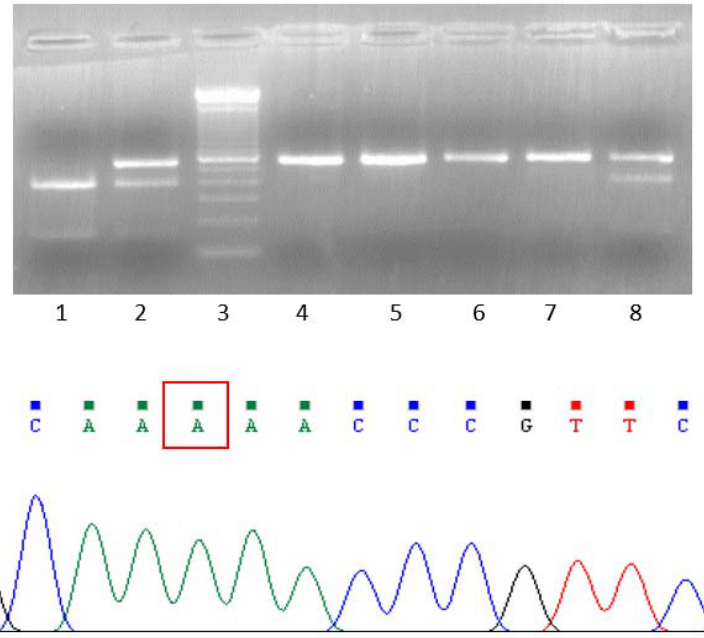
Figure 1. Melanoma tumors showing homozygosity of MITF-E318K variant in patient EW29/Pt5. Electrophoresis of the PCR-RFLP for the detection of MITF-E318K variant in melanoma lesions of EW29/Pt5. Lane 1: negative wild type control; lane 2: positive control heterozygous for MITF-E318K; lane 3: molecular weight marker 110 bp; lanes 4–7: DNA from the four patient’s tumor samples showing homozygosity for the variant. The homozygous mutated sequence is shown in the lower panel; lane 8: patient EW29/Pt5 blood DNA showing heterozygous genotype for the variant. In the sequence the mutated base A is indicated.